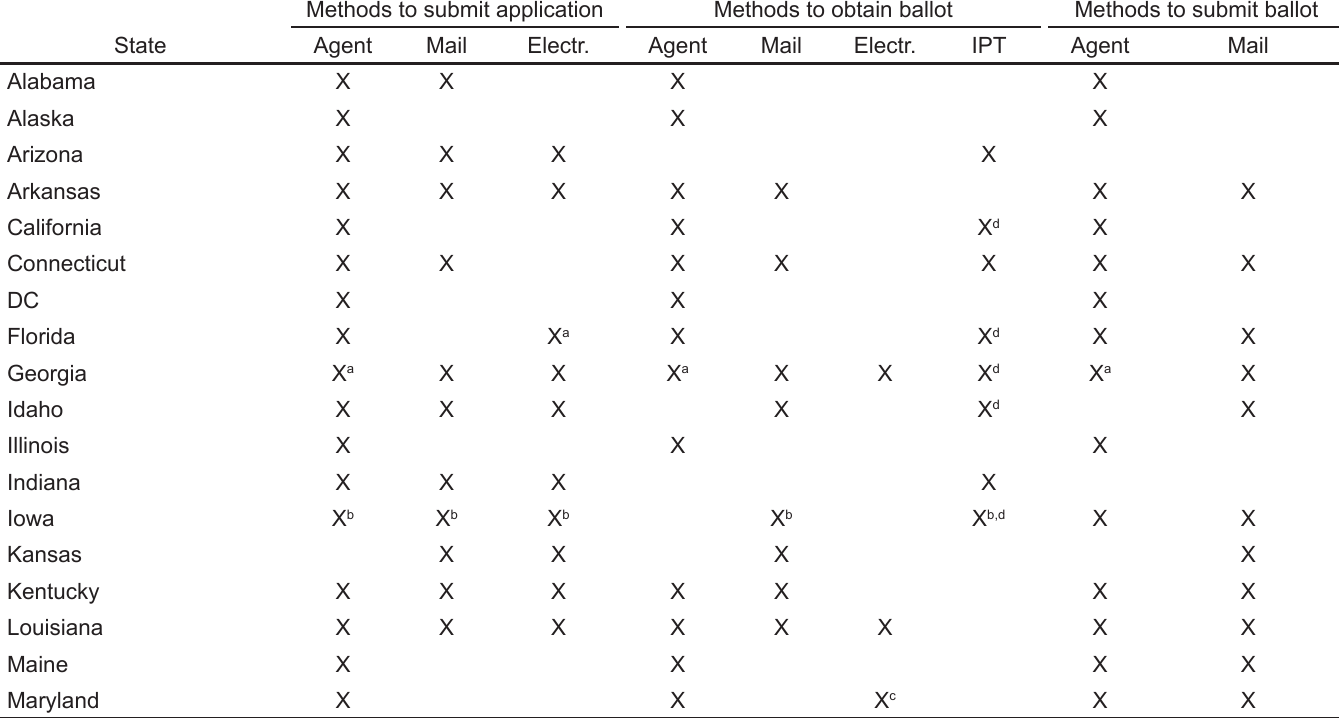
Table. Methods for submitting application, obtaining ballot, and returning